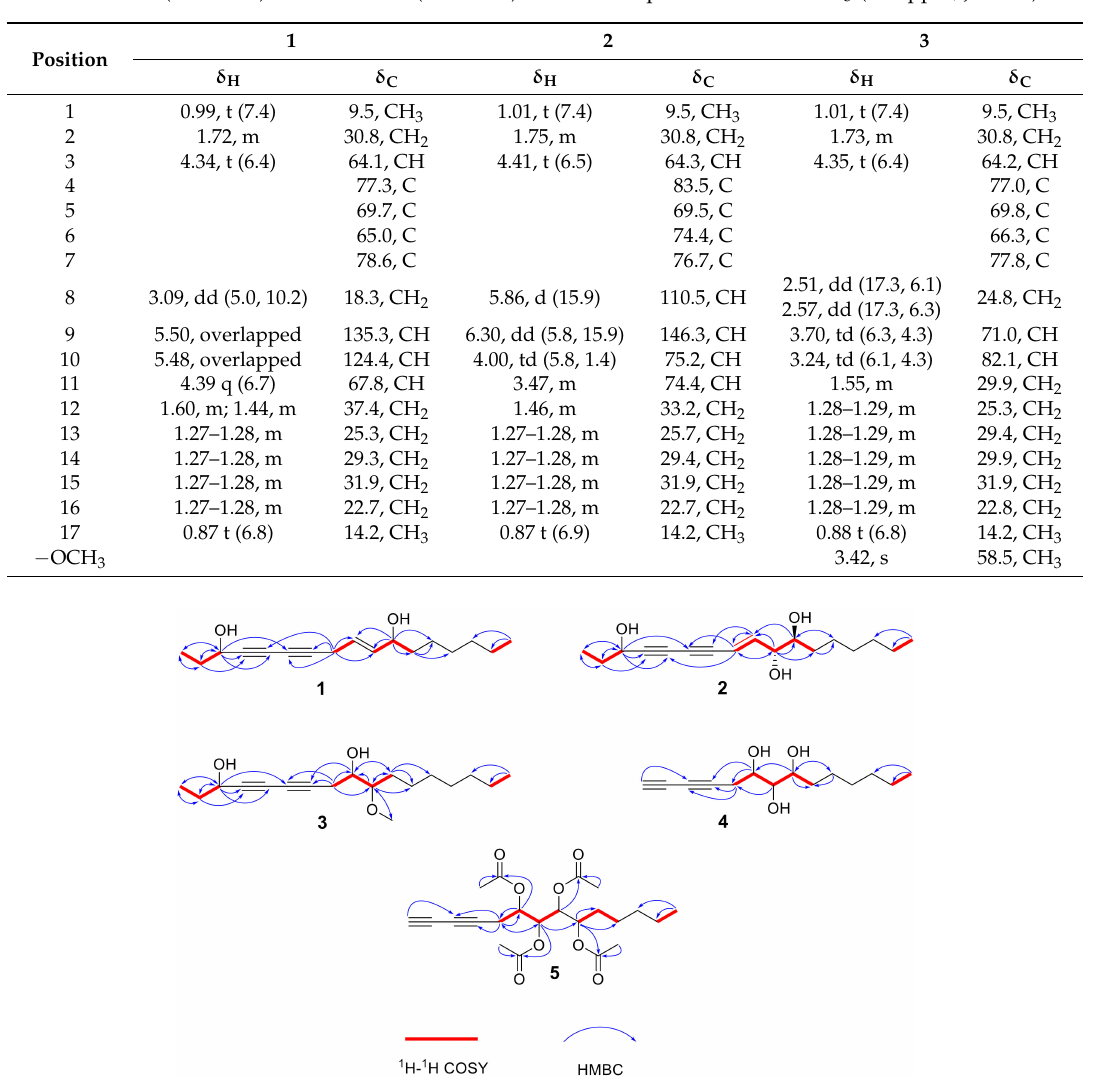
Table 1. 1 H (500 MHz) and 13 C-NMR (125 MHz) data for compounds 1 – 3 in CDCl 3 ( δ in ppm, J in Hz).